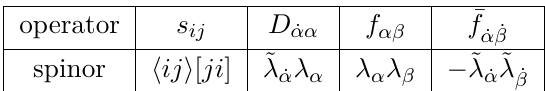
Table 2 . Dictionary between operators and on-shell